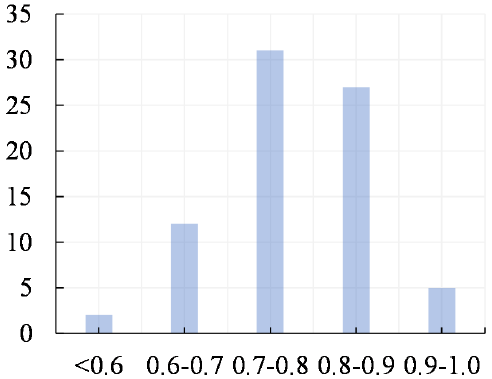
Figure 3. Test to decide metaknowledge association